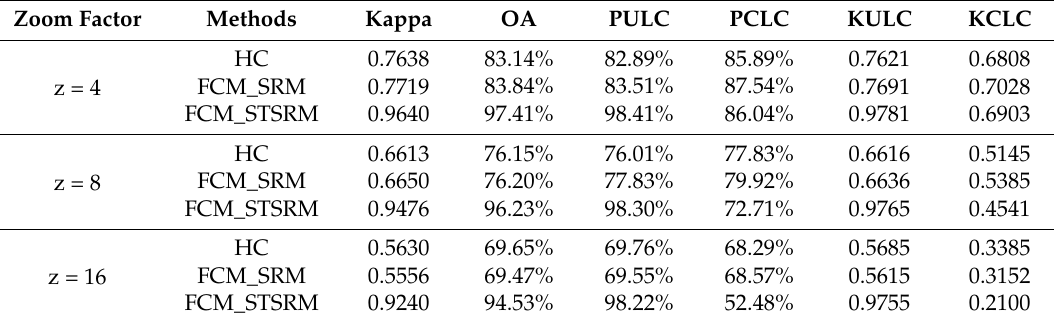
Table 1. Accuracy statistics of different methods at different zoom